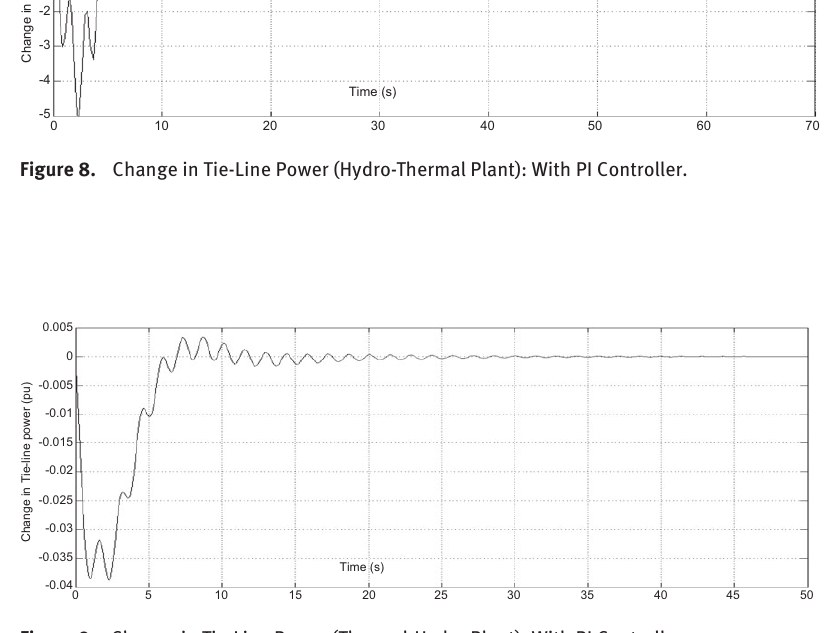
Figure 9. Change in Tie-Line Power (Thermal-Hydro Plant): With PI